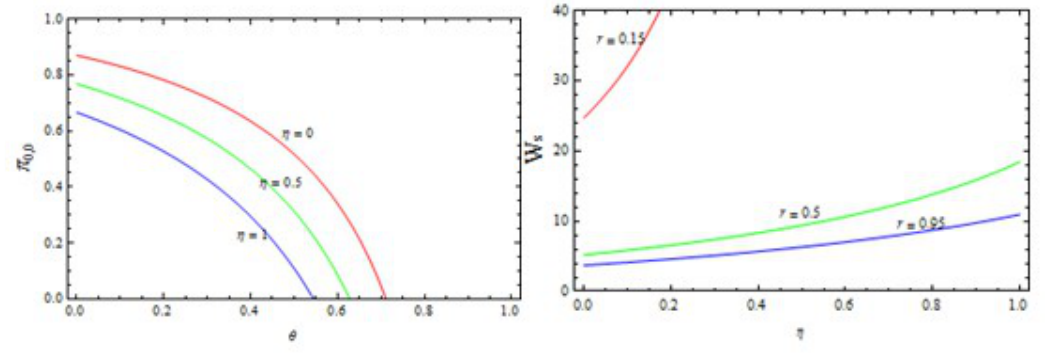
Figure 4. p 0,0 versus q for different h Figure 5. W s versus h for different r